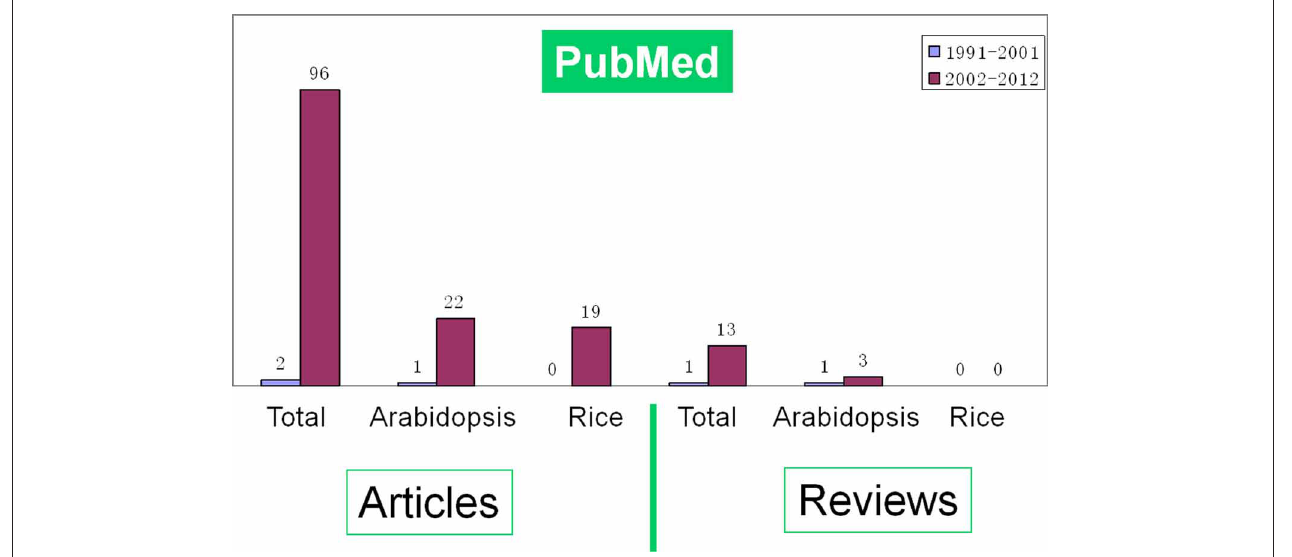
FIGURE 1 | A survey of the literatures indicates the growing number of proteomic research articles and reviews on seed germination in all species (total), Arabidopsis and rice respectively